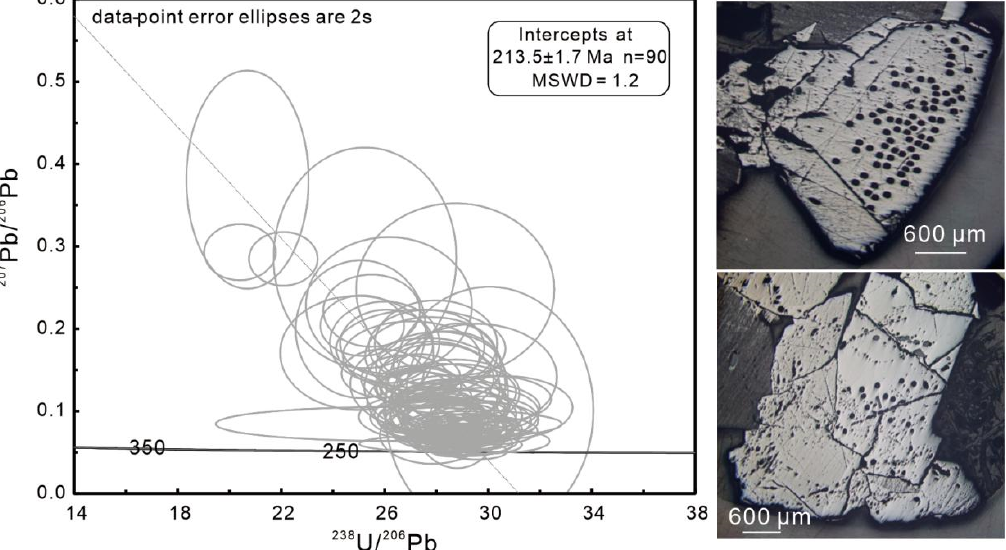
Figure 5. LA-MC-ICPMS cassiterite U–Pb age of the beryl-, cassiterite-, and scheelite-bearing quartz vein in the Wuzhutang granite from the Xuebaoding mining area, Sichuan Province, China.